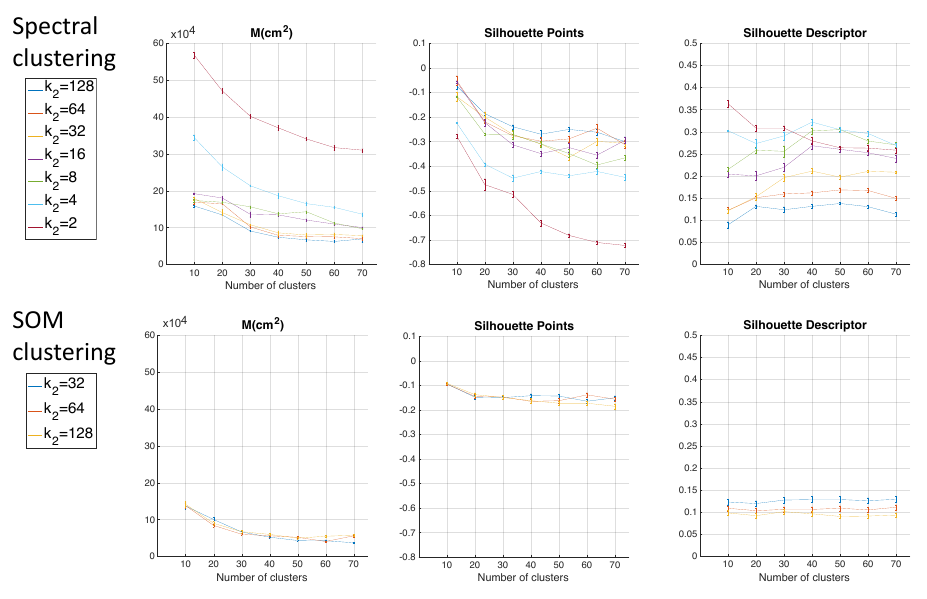
Figure 13. Results of the two clustering methods: average moment of inertia, average silhouette of points, and average silhouette of descriptors vs. number of clusters, when using HOG in the Saarbrücken